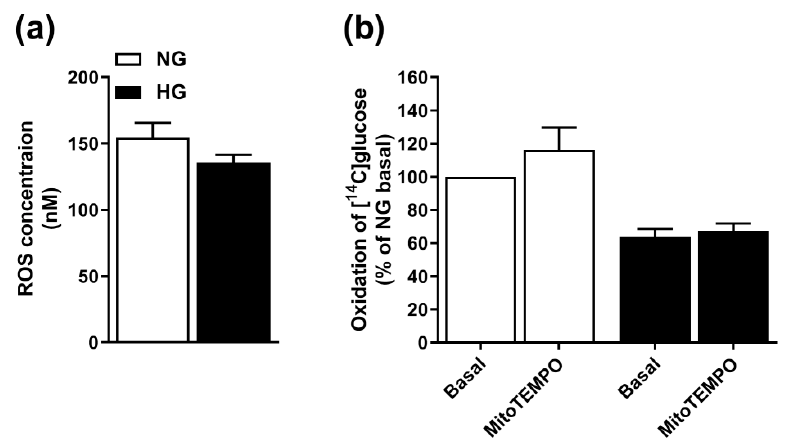
Figure 3. Involvement of reactive oxygen species (ROS). ( a ) Myotubes were exposed to 20 mM glucose (hyperglycemia, HG) the last four days of the differentiation period and ROS production in HG versus normoglycaemic (NG) myotubes were calculated from a standard curve (OxiSelect intracellular ROS assay kit). Results are presented as means ± SEM from five individual experiments (n = 5). ( b ) Effect of the ROS-scavenger MitoTEMPO on glucose oxidation. Results are presented as means ± SEM in % of NG basal from four individual experiments (n = 4).